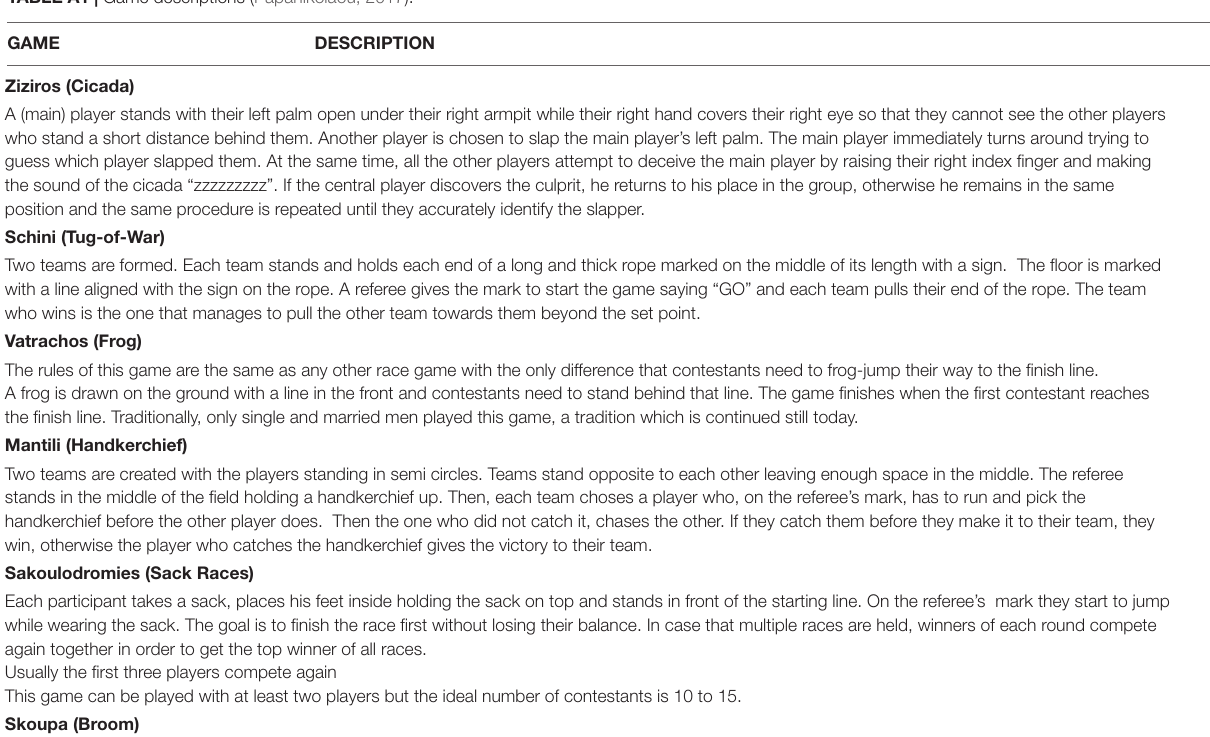
TABLE A1 | Game descriptions (Papanikolaou,